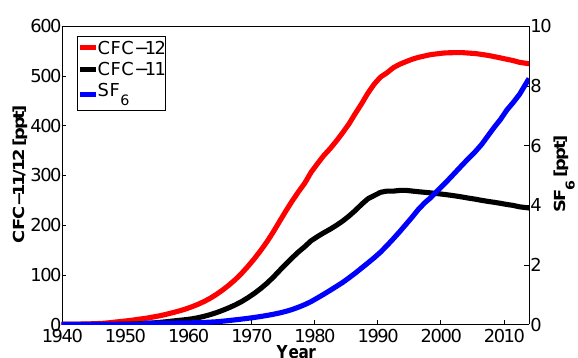
Figure 1. Atmospheric histories of CFC-12, CFC-11 and SF 6 of the Northern Hemisphere. The data were taken from Bullister